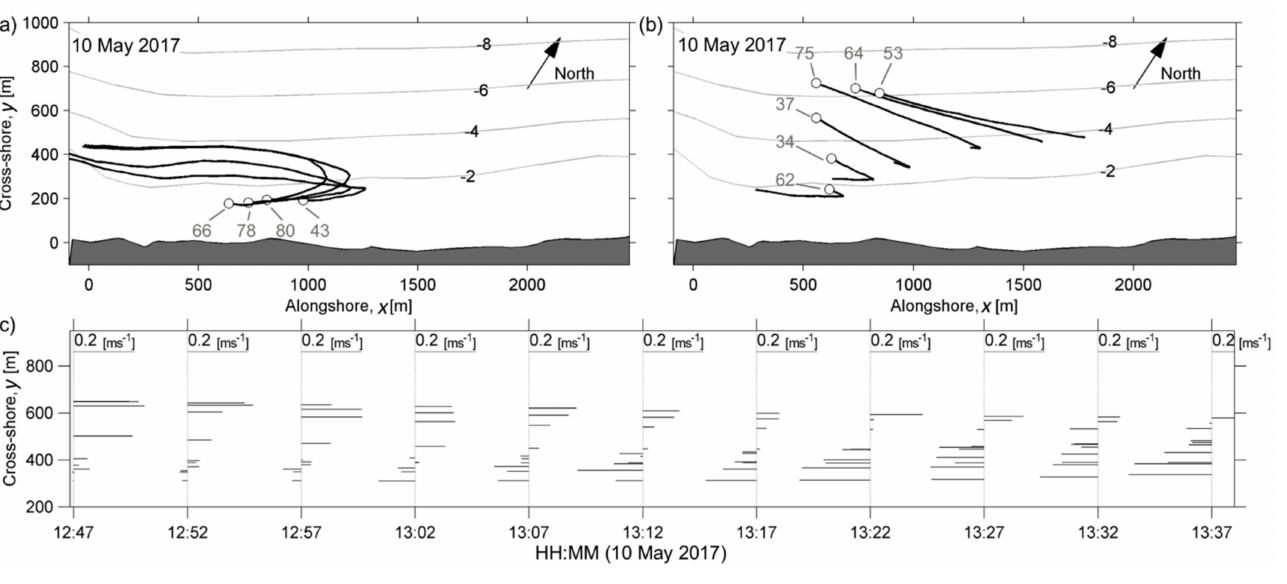
Figure 6. Case III experiment. Similar to Figure 4. ( a,b ) Trajectories of drifter clusters. ( c ) Alongshore velocity component measured by the sea-surface drifter